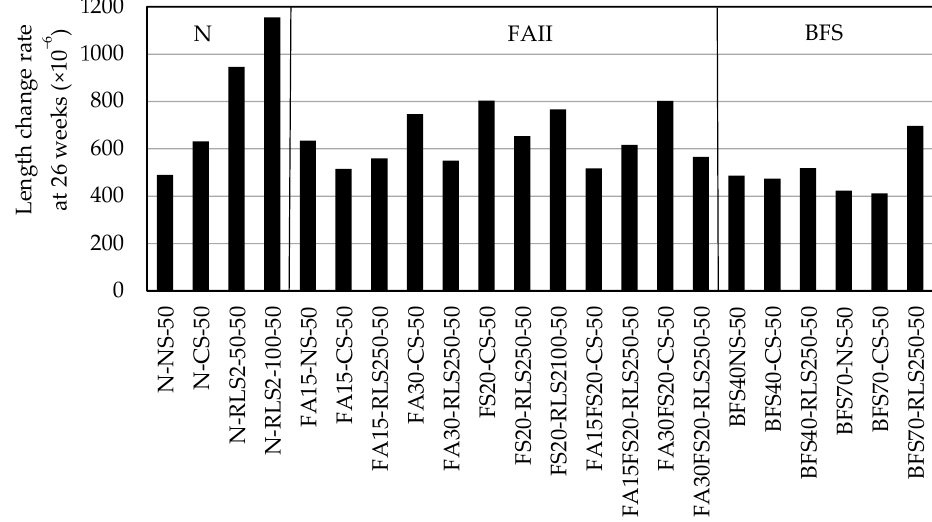
Figure 3. Length change rate of mortar.